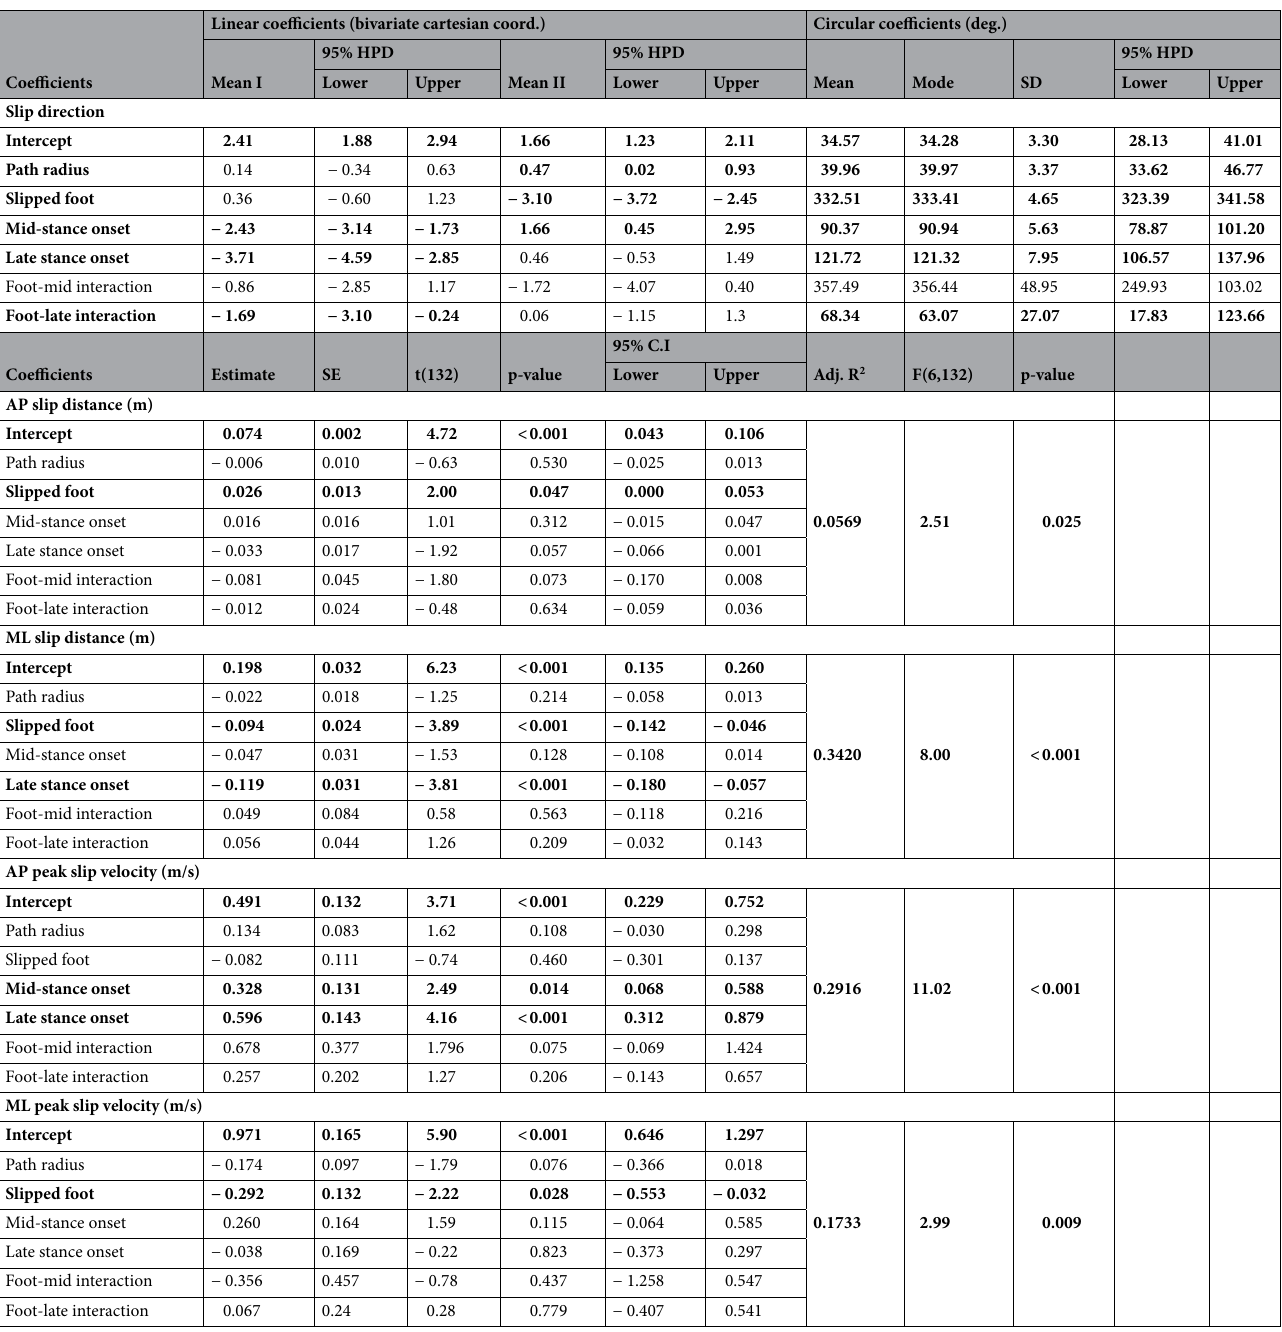
Table 2. Results from the circular and linear mixed-effects models generated for each slip outcome variable. Statistically significant predictors of each outcome are in